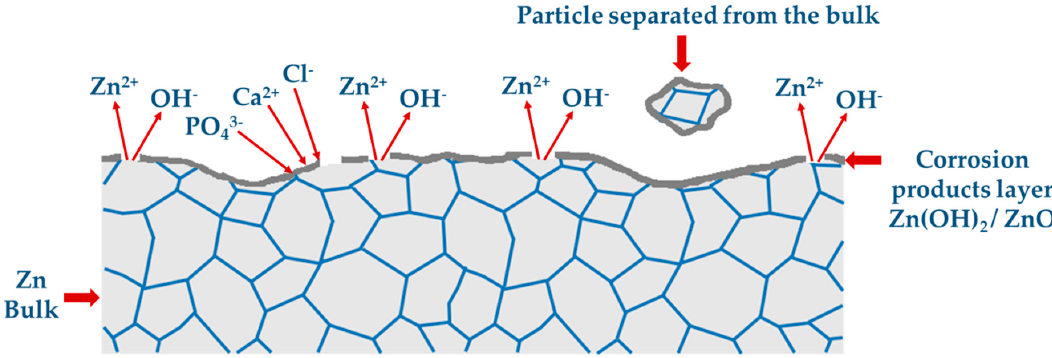
Figure 1. Model of the zinc degradation process in physiological fluids.